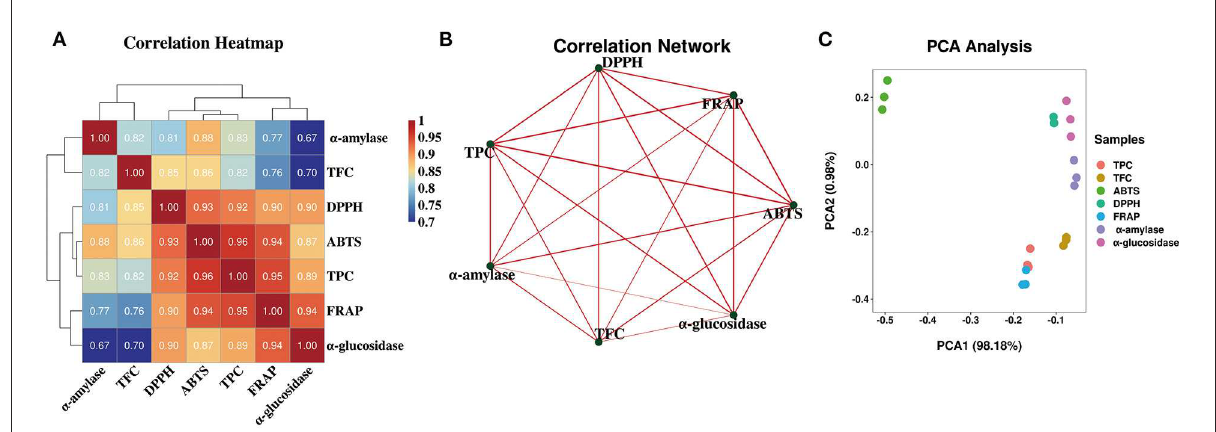
FIGURE3 Heatmap graph of correlation analysis and principal component analysis (PCA) of diferent samples and indicators. (A) Correlation heatmap. (B) Correlation network. (C) PCA analysis. P -value (ranging from 0 to 1) and corresponding color (red to blue) represented the magnitude of the Pearson correlation.